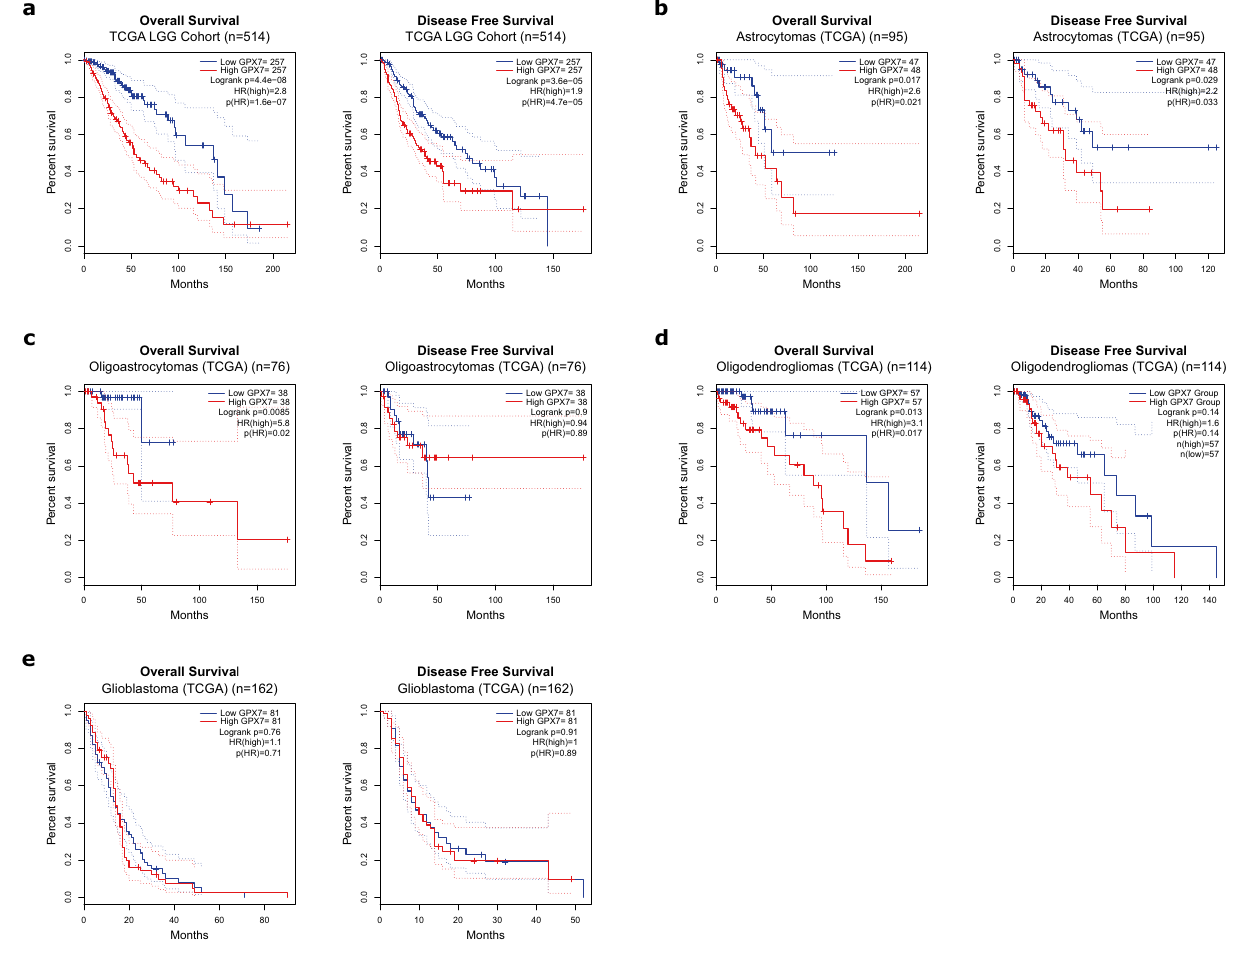
Figure 4. Kaplan–Meier survival curves are based on high (red) and low (blue) expression of GPX7 in LGG and GBM from the TCGA database . Overall survival (OS) (left) and disease-free survival (DFS) (right) of ( a ) All histological subgroups of LGG (n = 514), ( b ) Astrocytomas (n = 95), ( c ) Oligoastrocytomas (n = 76), ( d ) Oligodendrogliomas (n = 114) and ( e ) Glioblastomas (n = 162). X-axis: patients’ survival duration (months); Y-axis: patients’ survival rate. p -Values for all survival analyses have been calculated using the log-rank